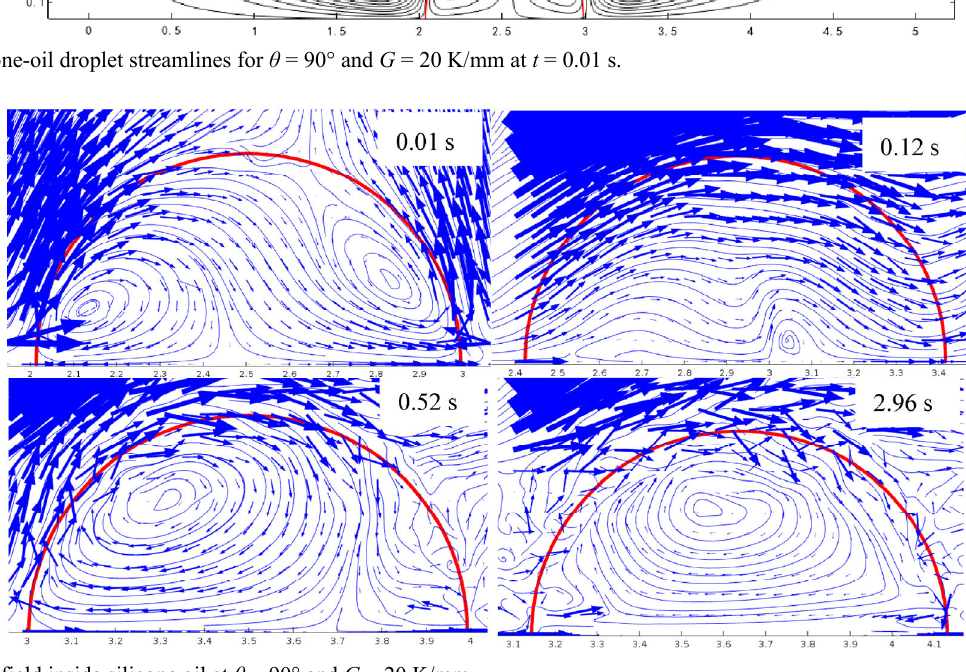
Fig. 6 Flow field inside silicone oil at θ = 90° and G = 20